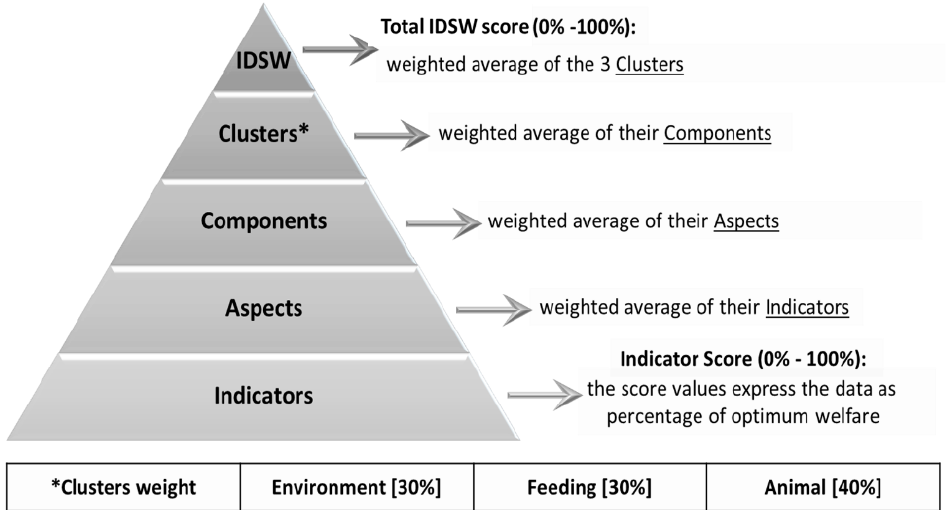
Figure 1. Hierarchical structure and scoring system adopted in the Integrated Diagnostic System Welfare (IDSW) model.